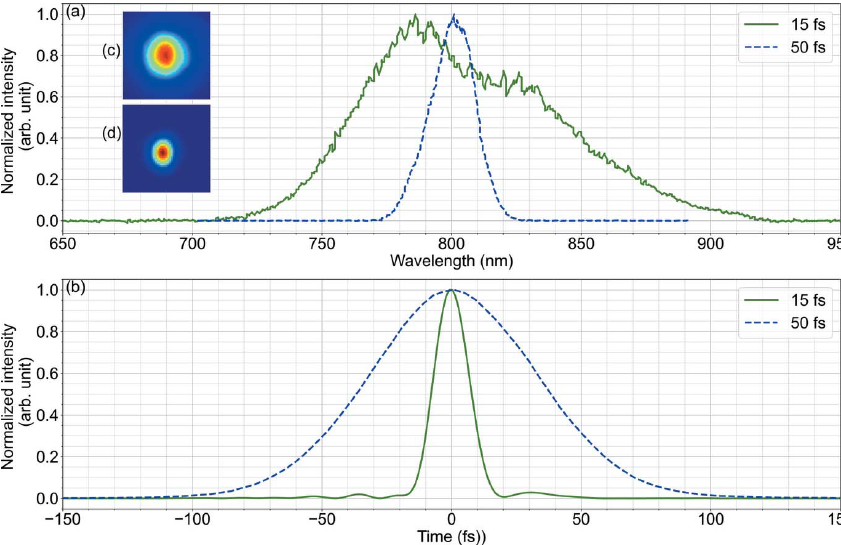
Figure 3 Spectral ( a ) and temporal ( b ) profile of the PP laser at 15 fs FWHM and 50 fs FWHM pulse duration. The insets show the beam profile in the near-field ( c ) and far-field ( d